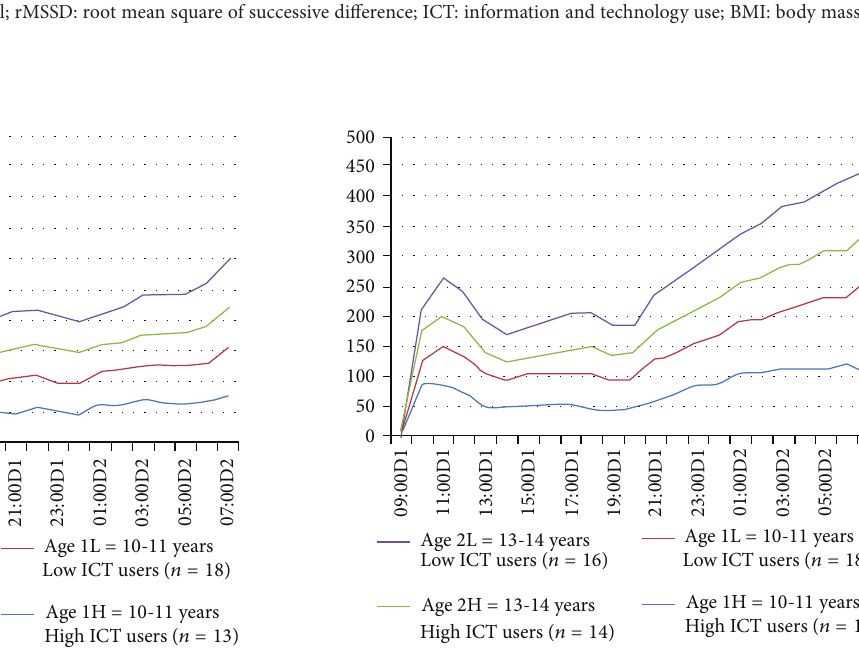
Figure 1: Mean HRV (SDNN, ms) during a school day and at night.